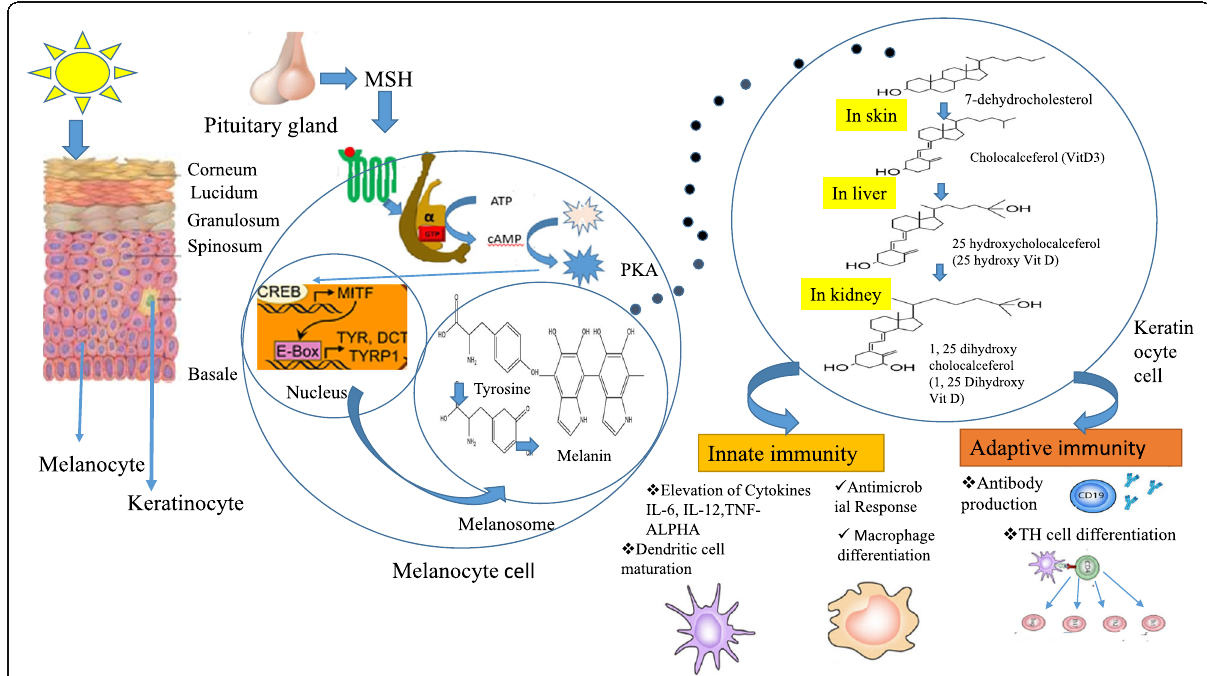
Fig. 1 Schematic representation of the cross road between sunlight, vitamin D synthesis, activation of melanocytes and their regulation of immune